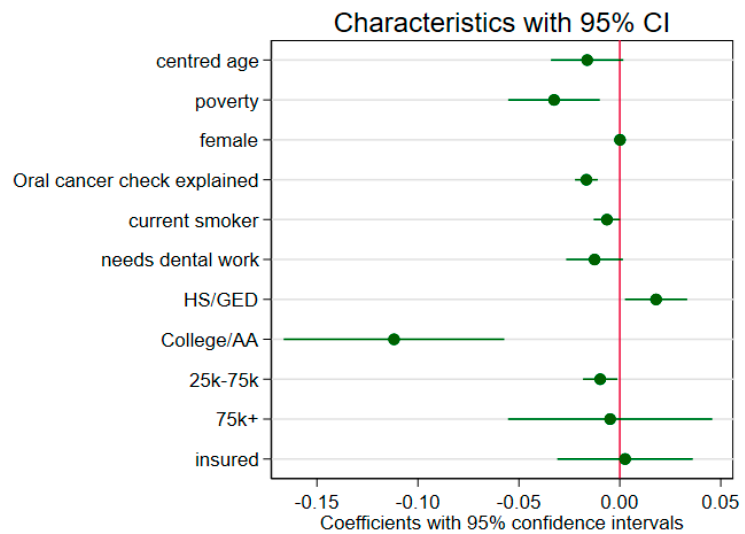
Figure 1. Coefficient plot of the decomposed characteristics with 95% confidence intervals. HS/GED — High School/General Educational Development